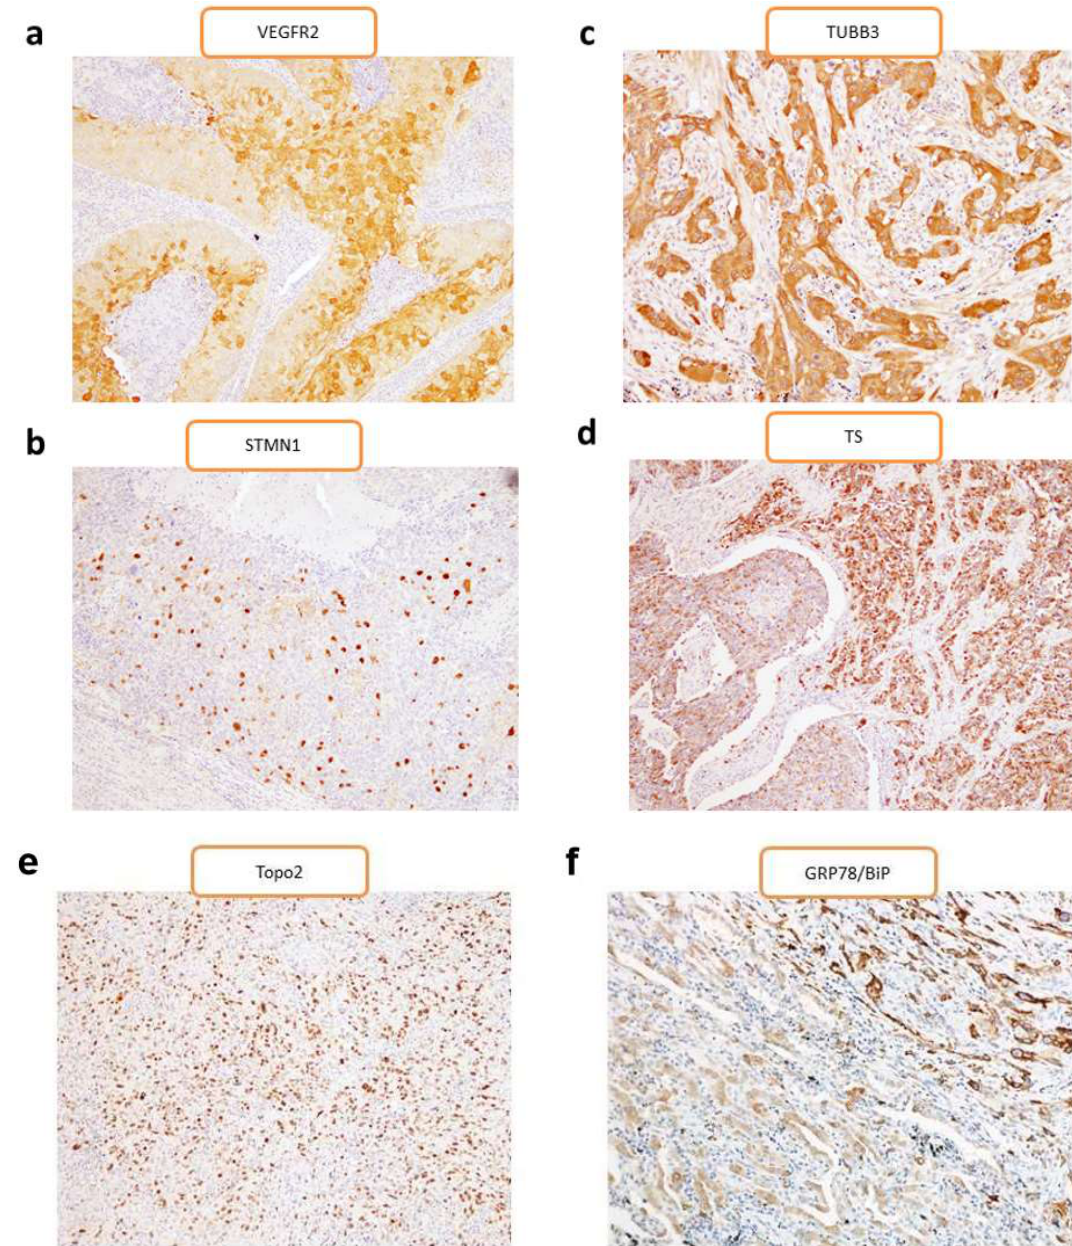
Figure 1. Representative image of immunohistochemical staining in patients with pulmonary pleomorphic carcinoma (PPC). ( a ) Immunopositivity for VEGFR2 in resected samples was observed mainly in the cytoplasm, with some samples also showing positive staining on the cellular membrane. ( b ) Immunopositivity for STMN1 showed a score of grade 4 and positive staining in the cytoplasm. ( c ) Immunopositivity for TUBB3 showed an H-score of 7 and positive staining in the cytoplasm. ( d ) Immunopositivity for TS showed a score of grade 5 and positive staining in nuclei and the cytoplasm. ( e ) Immunopositivity for Topo-II showed a score of grade 5 and positive staining in nuclei. ( f ) Immunopositivity for glucose-regulated protein and 78 kDa (GRP78 / BiP) showed a score of grade 5 and positive staining in the cytoplasm. STMN1, stathmin 1; Topo-II, topoisomerase II; TS, thymidylate synthase; TUBB3, tubulin β 3 class III; VEGFR2, vascular endothelial growth factor receptor 2. Original magnification, ×